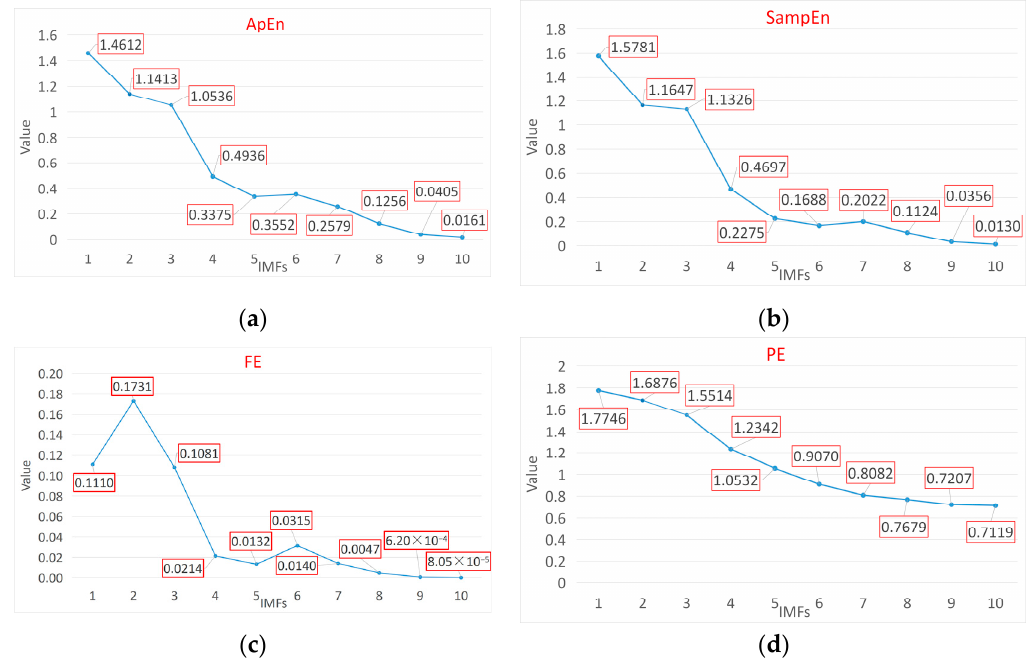
Figure 5. Variation law of different entropies. ( a ) ApEn; ( b ) SampEn; ( c ) FE; ( d ) PE.